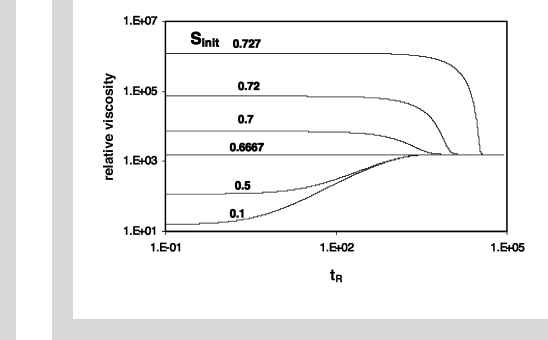
Figure 7: Evolution of h (t) resulting from applying a constant stress, following rest periods of increasing lengths (thus leading to growth of S , init however bounded by S ): m (a – left) s < s with B S = 0.729 and S =0.833. m eq (b) s > s with S = 0.729 B m and